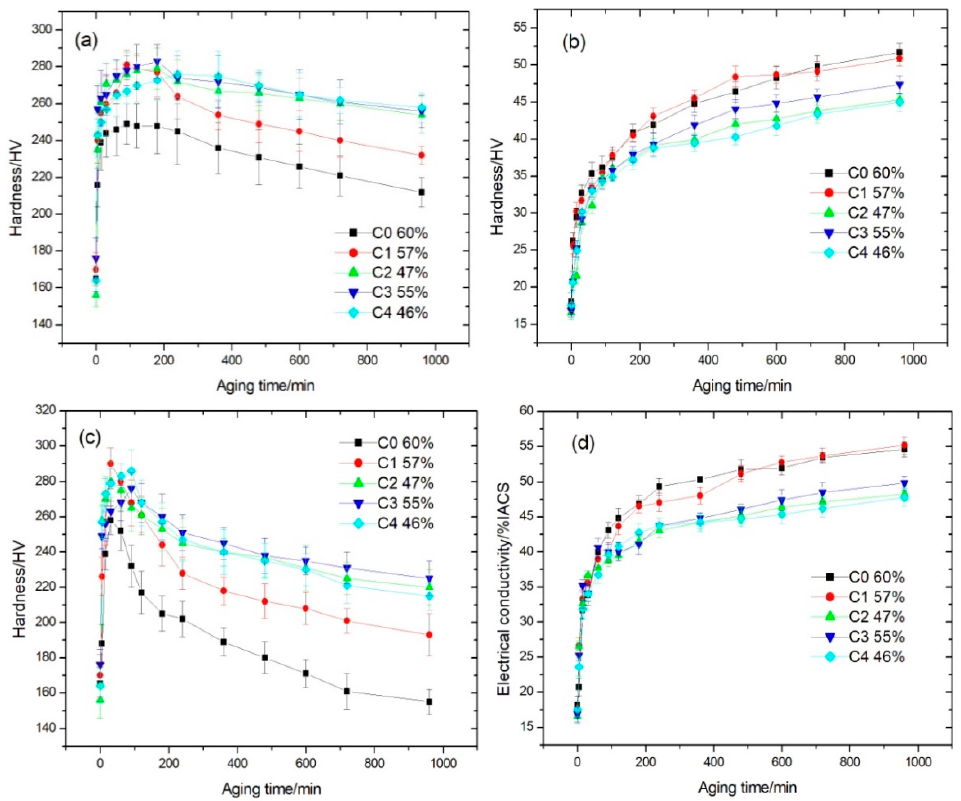
Figure 2. Hardness and electrical conductivity curve of cold rolled Cu-Ni-Co-Si-P-Mg alloys as a function of aging time at different aging temperature. ( a ) hardness, aging at 450 °C, ( b ) electrical conductivity, aging at 450 °C, ( c ) hardness, aging at 500 °C, ( d ) electrical conductivity, aging at 500 °C.